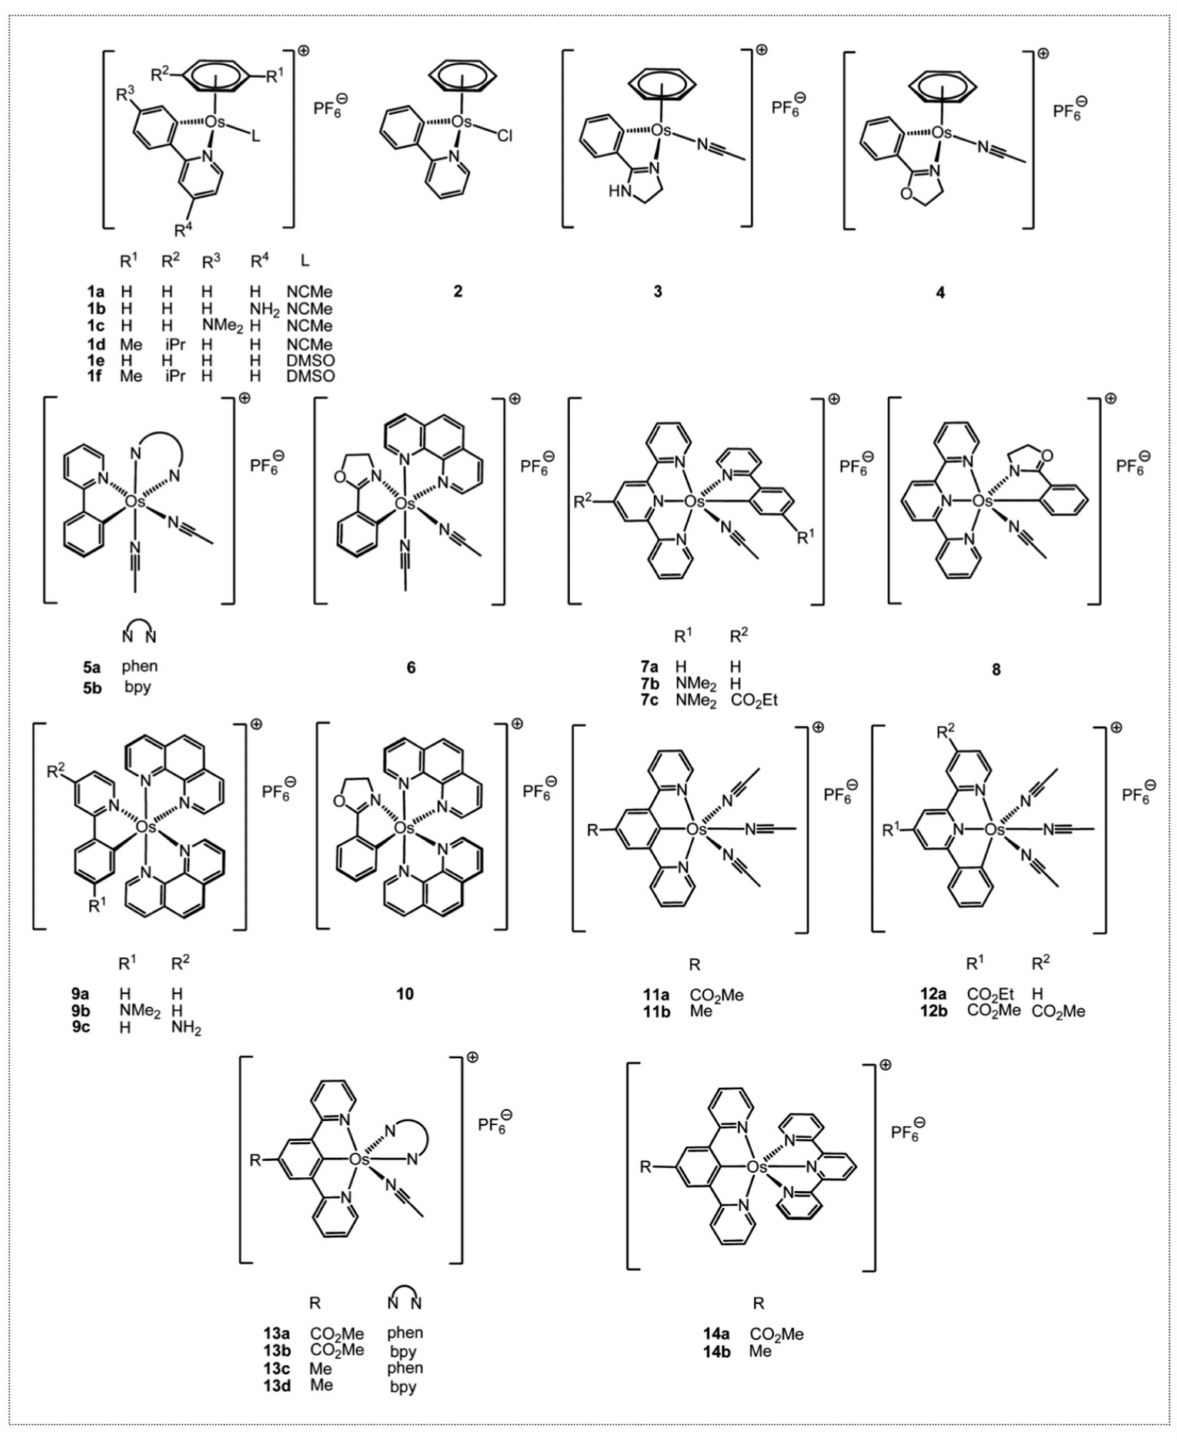
Figure 8. Osmium organometallic complexes designed and synthesized by Dr. Michel